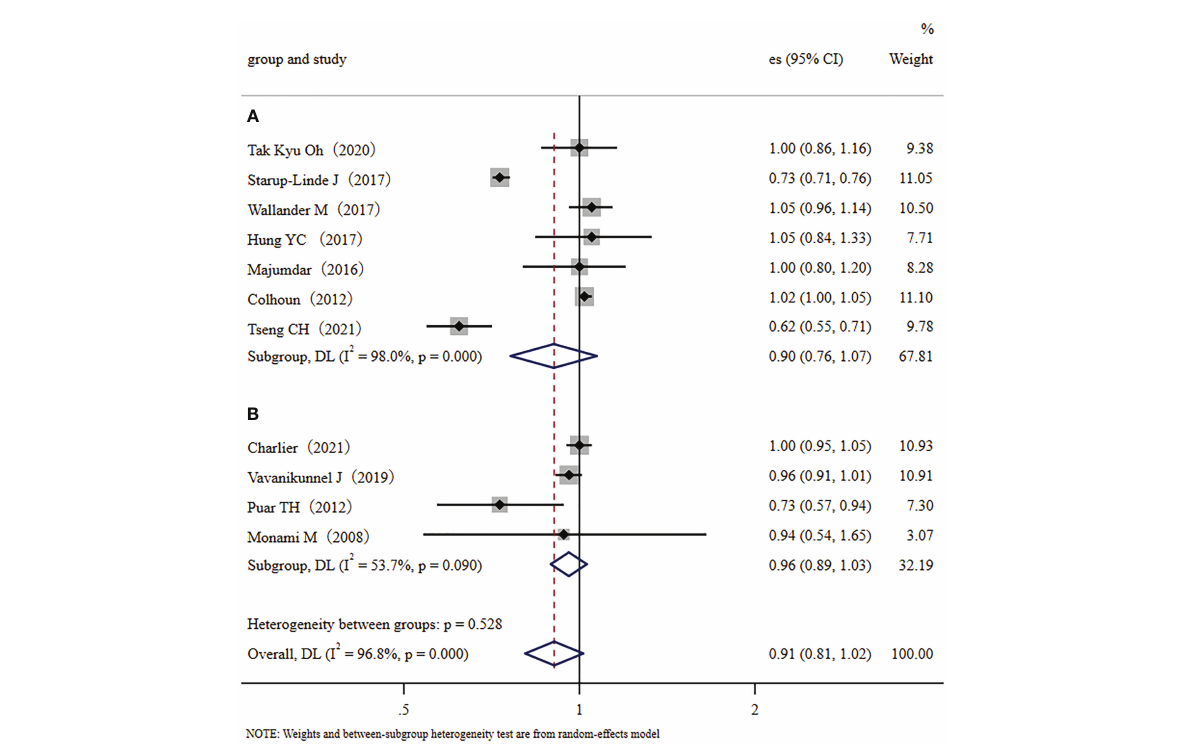
FIGURE 3 The cohort/case-control subgroup analysis: (A) : Forest plot of the included Cohort studies that examined the association between metformin application and fracture risk in type 2 diabetic patients; (B) : Forest plot of the included Case-control studies that examined the association between metformin application and fracture risk in type 2 diabetic patients. (Study: author and year of publication; es, effect size; 95% CI, 95% con fi dence interval; Weight,